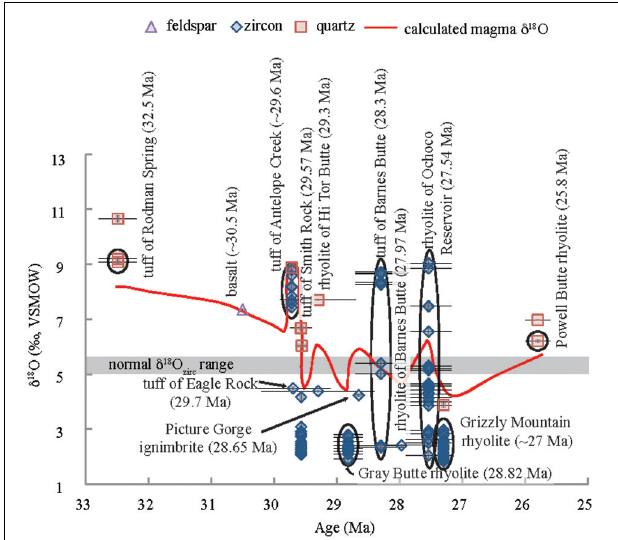
FIGURE 6 | δ 18 O vs. ε Hf i data for zircons of the studied calderas. ε Hf i values for the Picture Gorge Ignimbrite, the rhyolite of Hi-Tor Butte, the Tuff of Barnes Buttes, and the Tuff of Eagle Rock are average values for the Crooked River caldera, since they were analyzed for δ 18 O and not ε Hf, and are symbolized by a blue square with a dashed border. ε Hf i depleted mantle value is from Nowell et al. (1998). The range in ε Hf i values of zircons from the Blue Mountains Province is from Schwartz et al.